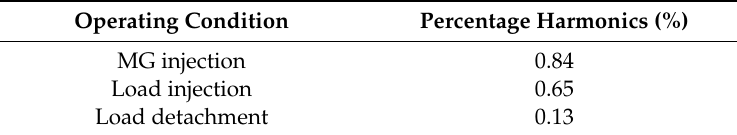
Table 4. FFT analysis understudied operating conditions.